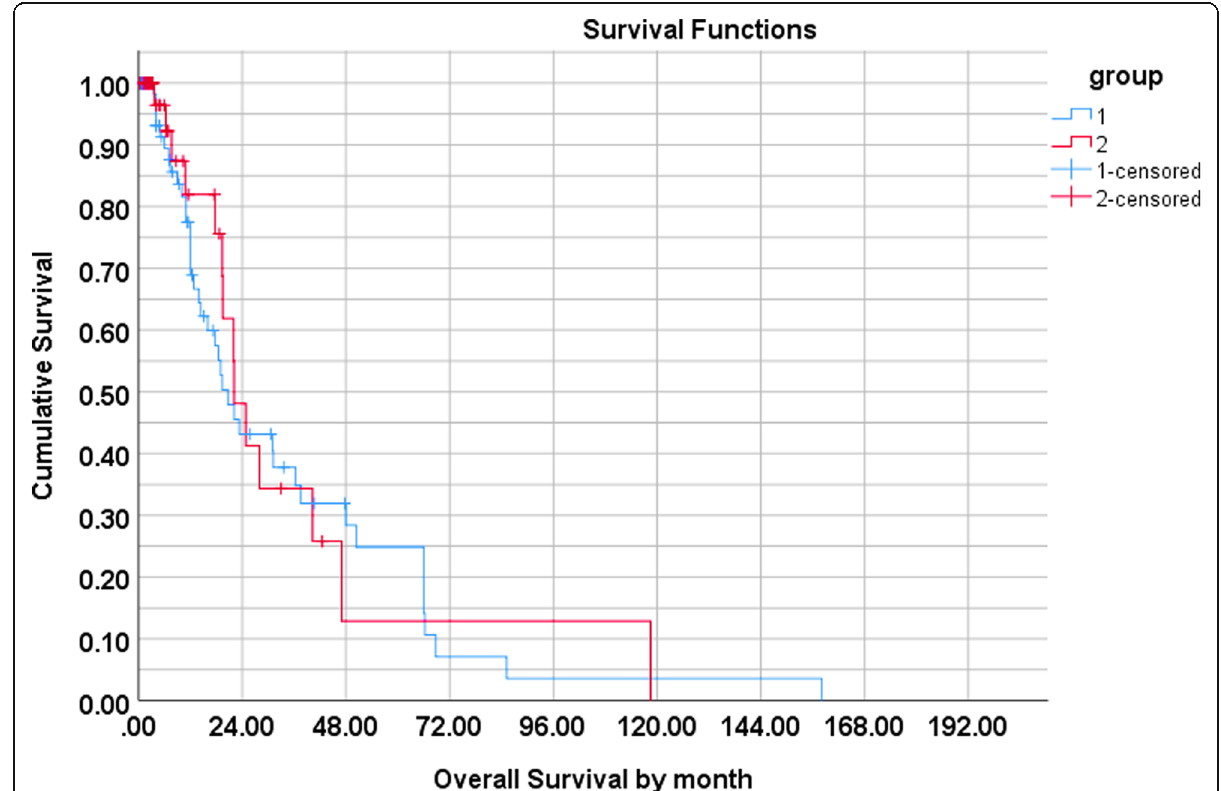
Fig. 1 Overall survival by Kaplan-Meier survival curve in ALL patients treated with either TBI/Cy (group 1) or Bu/Cy (group